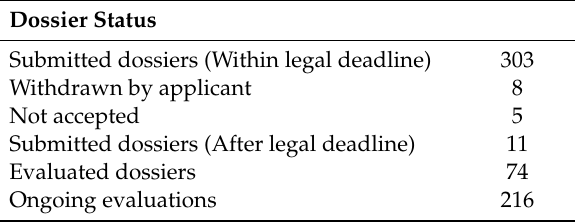
Table 1. Overview of all submitted food enzyme dossiers to the European Commission for evaluation and incorporation in the community list, according to European Commission (EC) No. 1332 / 2008. Dossiers that were withdrawn, not accepted, or submitted after the legal deadline are also indicated. Lastly, the current status of performed evaluations is given.